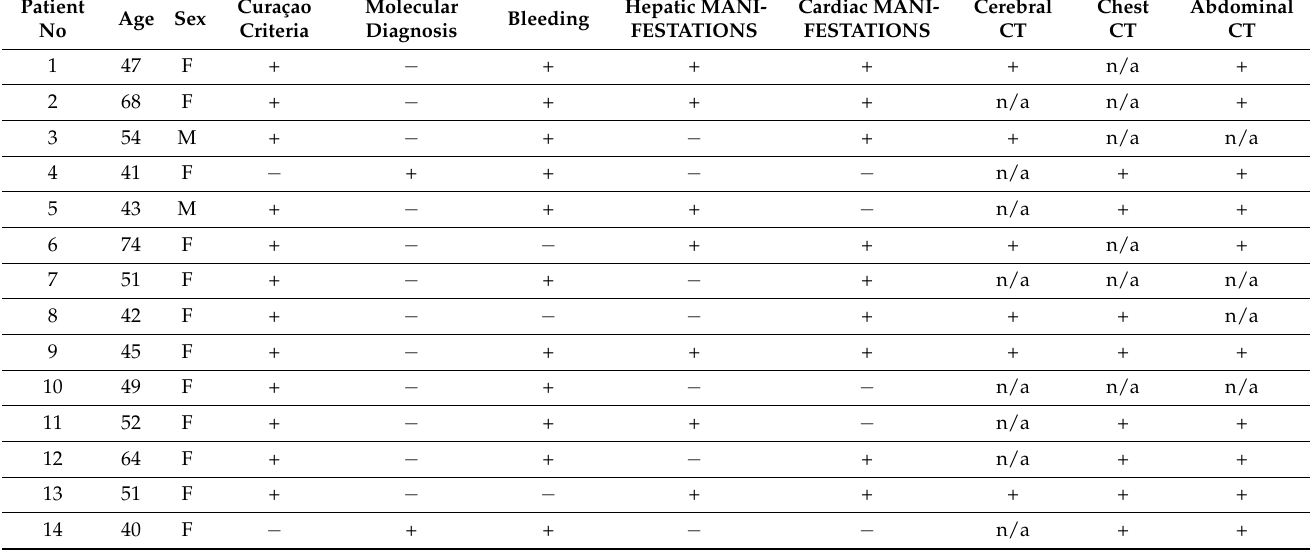
Table 1. Clinical manifestation of the 14